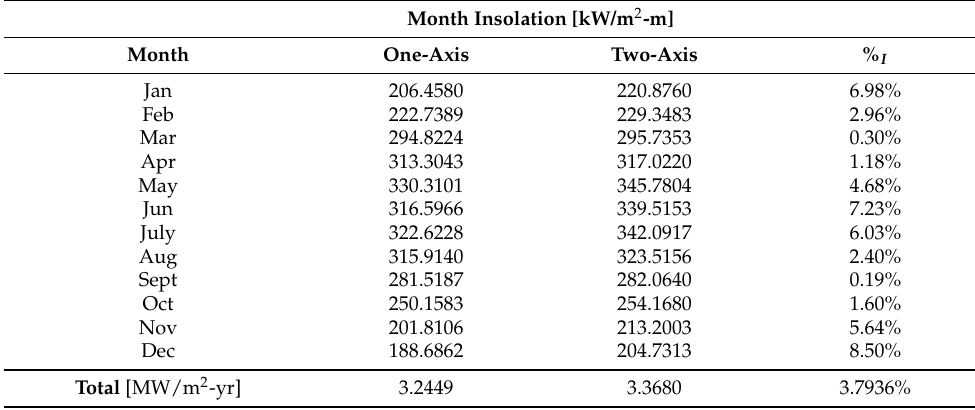
Table 8. Month and annual clear-sky insolation along with one and two-axis